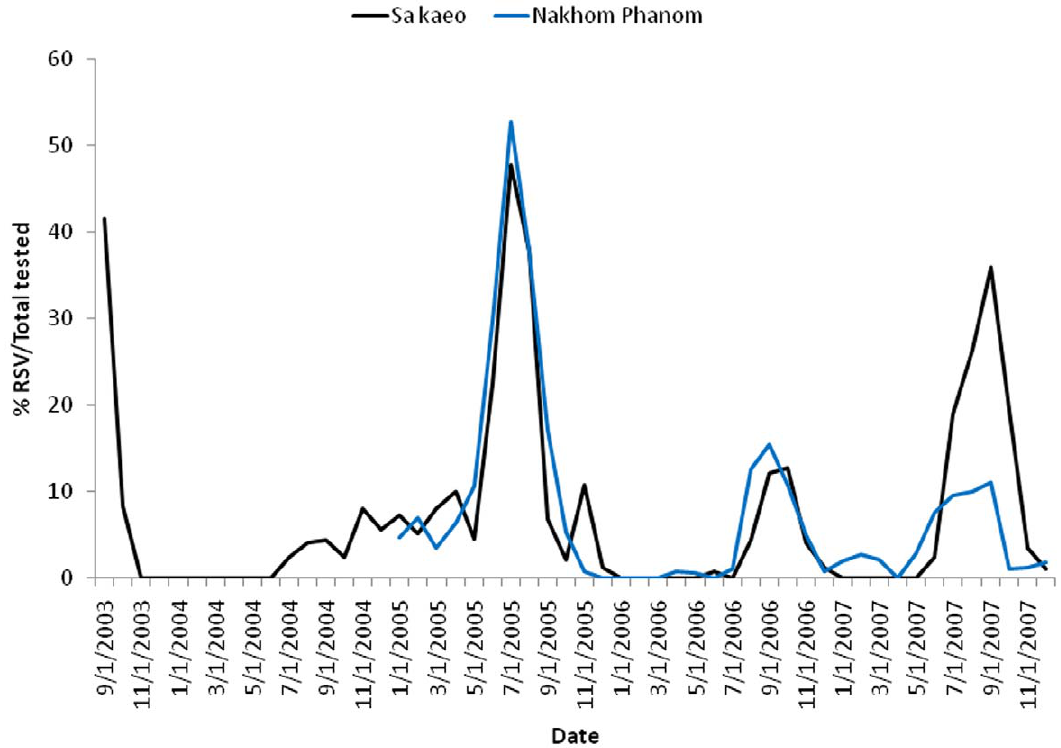
Figure 2. The percentage of patients with RSV infections per total patients tested by month and year among enrolled patients from SaKaeo (solid black line) and Nakhom Phanom (solid blue line) Provinces, September 1, 2003 – December 31, 2007.